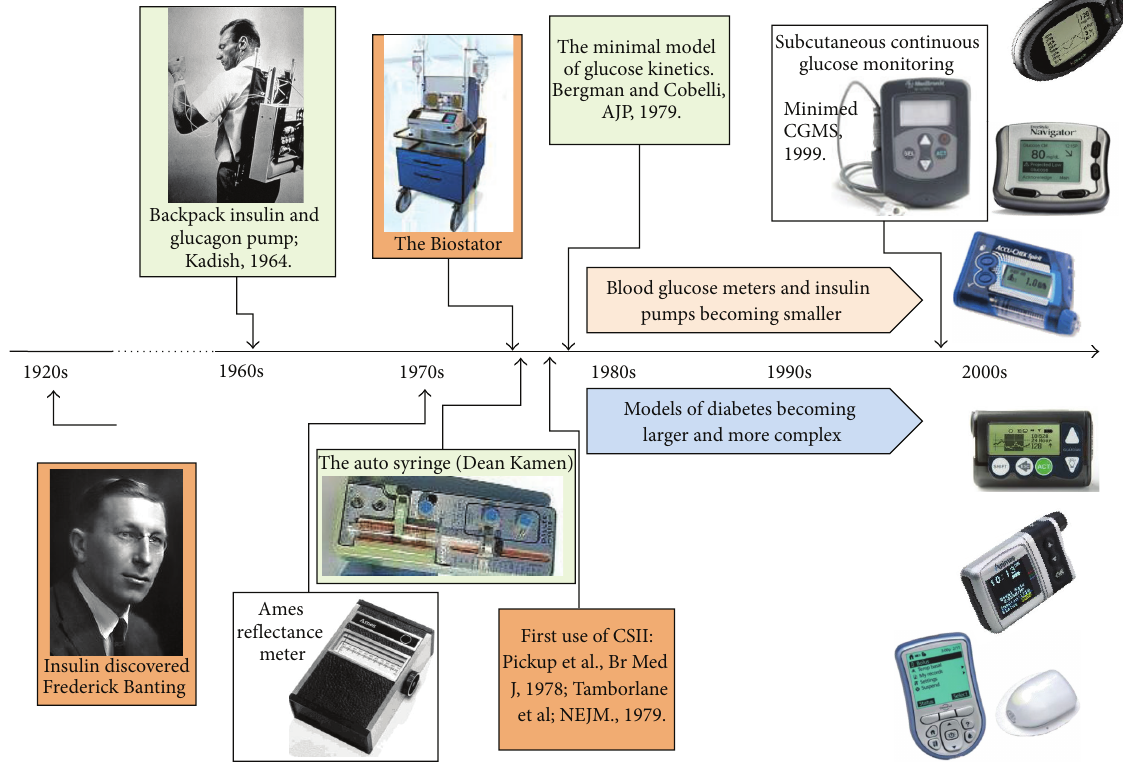
F 1: e Diabetes technology timeline from the discovery of insulin to the introduction of continuous glucose